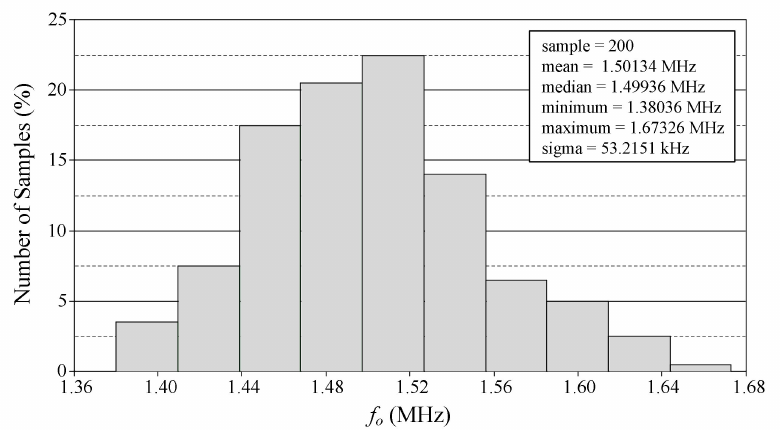
Figure 15. Histogram of f o distribution of the BP filter in